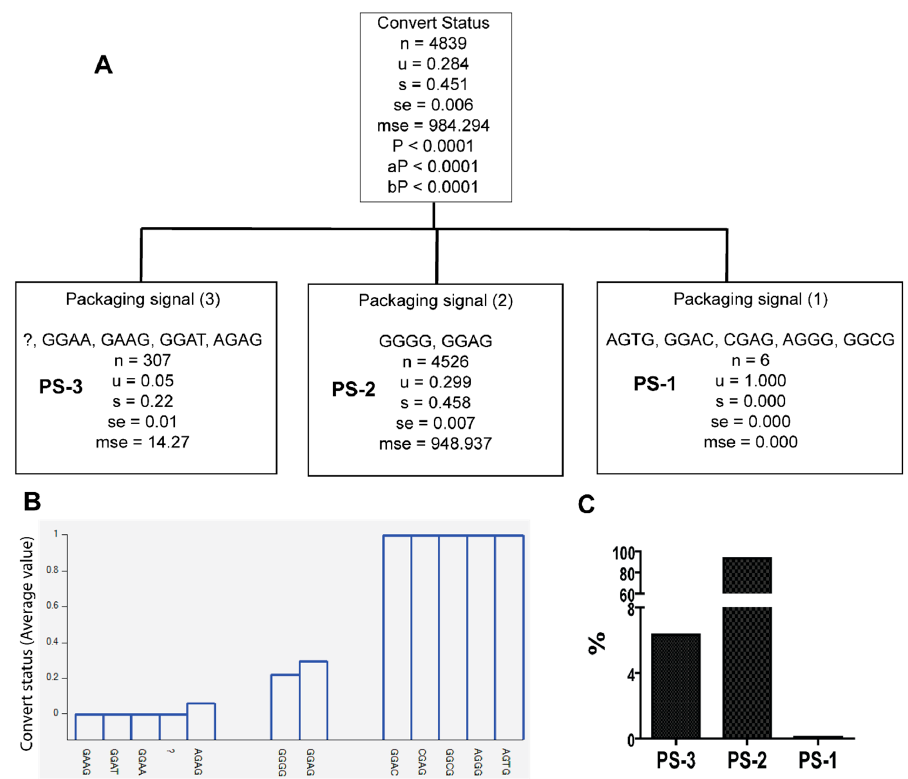
Figure 5. Classification of packaging signal (PS) sequence variants according to whether they were identified from late seroconverters ( u = 1) or early seroconverters ( u = 0). Note: question mark denotes lack of sequence. u— mean value; s—standard deviation; se—standard error; mse—mean square error; p—p value; aP—adjusted p value; bP—Bonferroni corrected p value. ( A ) Classification tree; ( B ) PS